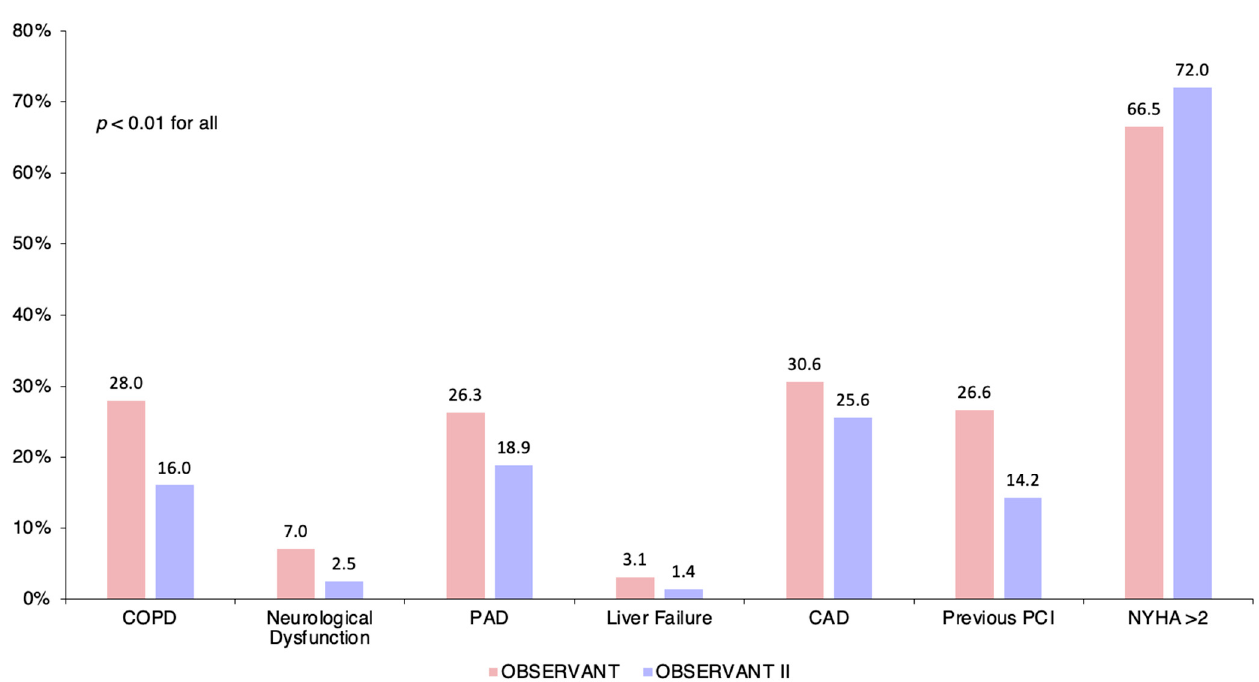
Figure 2. Crude baseline differences of patients undergoing transcatheter aortic valve implantation and enrolled in the OBSERVANT and OBSERVANT II studies. CAD, coronary artery disease; COPD, chronic obstructive pulmonary disease; NYHA, New York Heart Association; PAD, peripheral artery disease; PCI, percutaneous coronary intervention.